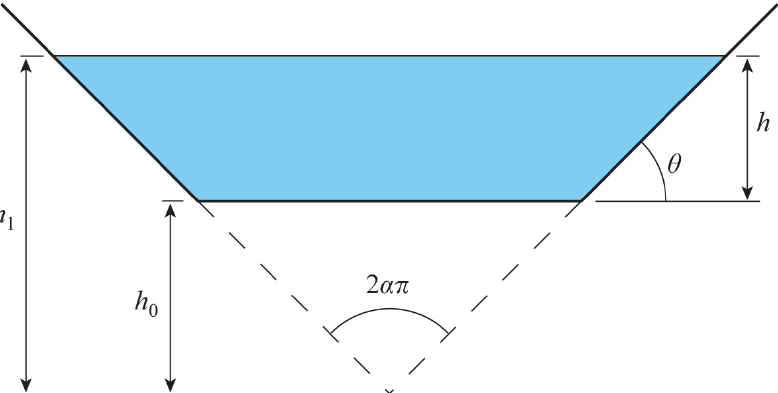
Figure 3. Schematic illustration of a sloped bottom tank with generic angle of embrace of the divergent lateral sides of 2 απ .